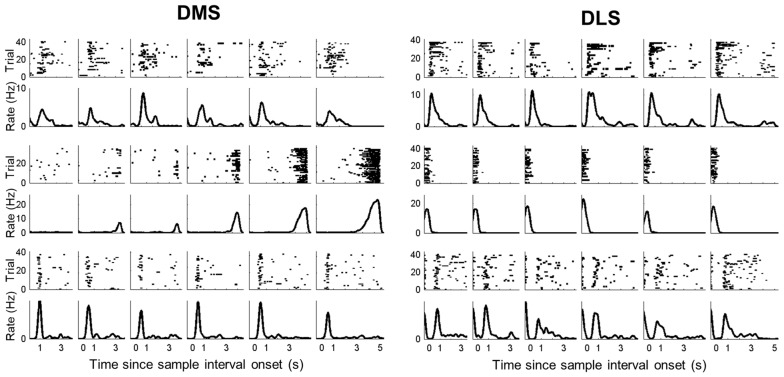
Examples of striatal neuronal activity during sample presentation. Spike raster plots and spike density functions (σ = 100 ms) of three DMS (left) and three DLS (right) MSNs. Trials were grouped according to sample interval length (left to right, short to long). The vertical lines indicate the onset of each time interval.